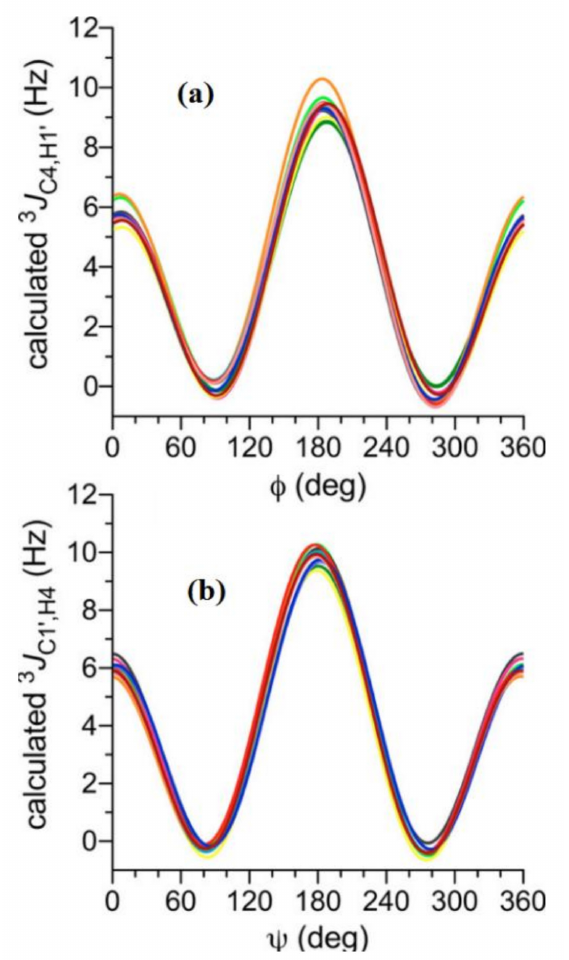
Figure 41. Calculated dihedral angle dependences of ( a )— 3 J (C-4,H-1 (cid:48) ) and ( b )— 3 J (C-1,H-4 (cid:48) ) in β -D-galactopyranosyl-(1 → 4)- β -D-glucopyranoside ( 78 ) as a function of ϕ and ψ . Reproduced from Zhang et al. [150] with the permission of the American Chemical